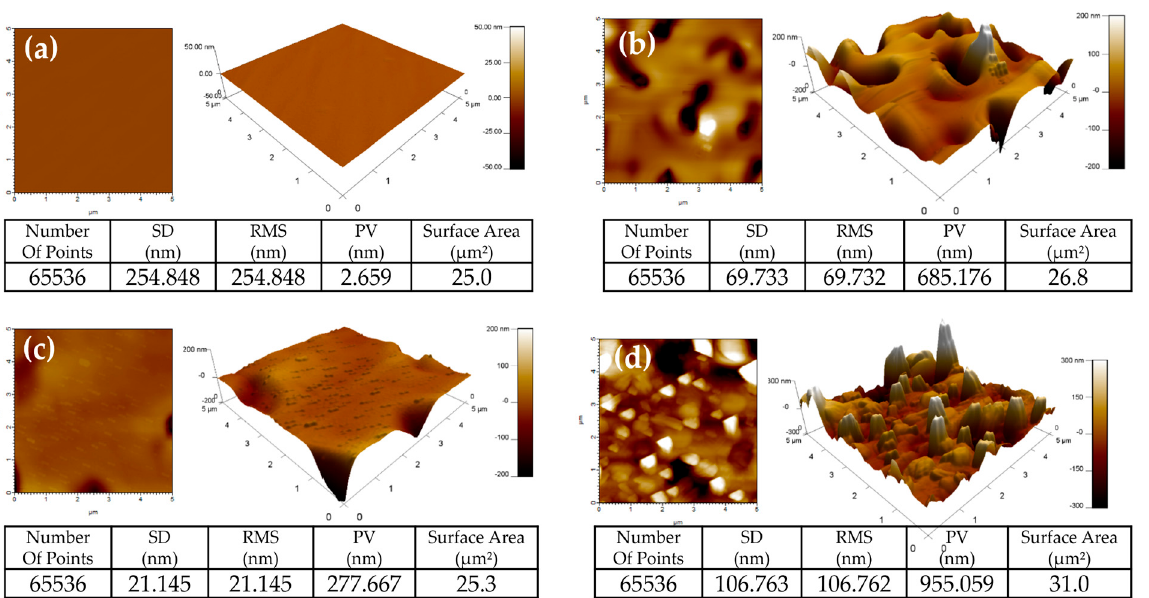
Figure 5. 2D and 3D AFM morphology images of ( a ) Ag layer, ( b ) Ag layer after annealing it at 600 ◦ C (Ag NPs), ( c ) Ag NPs/V 2 O 5 thin film, ( d ) Ag NPs/V 2 O 5 thin film/Au NPs after annealing at 600 ◦ C.